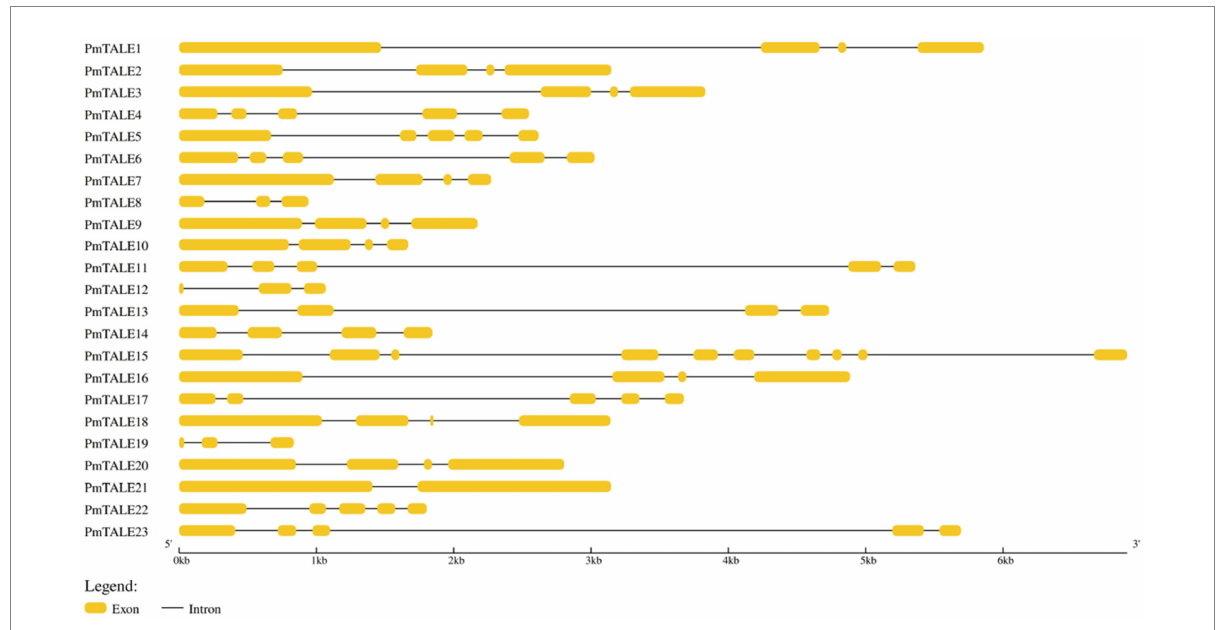
FIGURE 1 Schematic diagram of the exon-intron structure of the three-amino-acid-loop-extension (TALE) gene family members in Prunus mume.